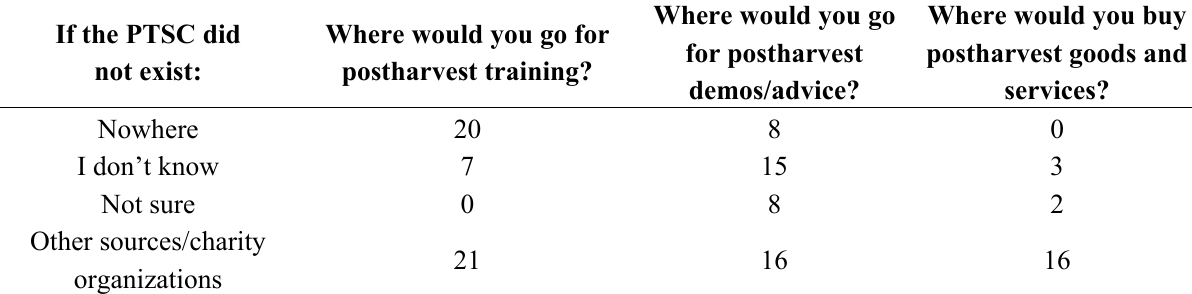
Table 3. Respondent ( n = 50) answers to queries on where to obtain postharvest tools, supplies, and